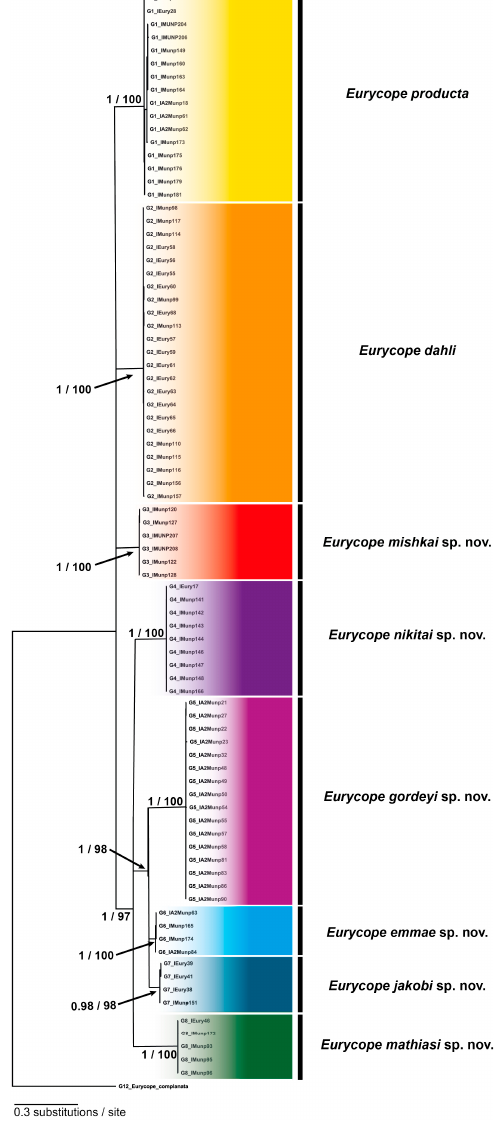
1 Figure 2. Consensus Bayesian tree for E. producta of the concatenated four gene loci dataset (16S, COI, 18S, and H3) of Schnurr et al. [28]. The branch lengths are proportional to the number of substitutions per site considering the models of nucleotide substitution estimated by MrAIC for the respective loci or partition. Posterior probabilities (>0.9) from Bayesian analyses and bootstrap percentages (>70) from maximum likelihood trees are indicated at the nodes. The names of the species are indicated next to the respective clade: E. producta sensu stricto, E. dahli , E. mishkai sp. nov., E. nikitai sp. nov., E. gordeyi sp. nov. , E. emmae sp. nov., E. jakobi sp. nov., and E. mathiasi sp. nov. The figure was reprinted and adapted from [28] by permission from Springer Nature, Marine Biodiversity